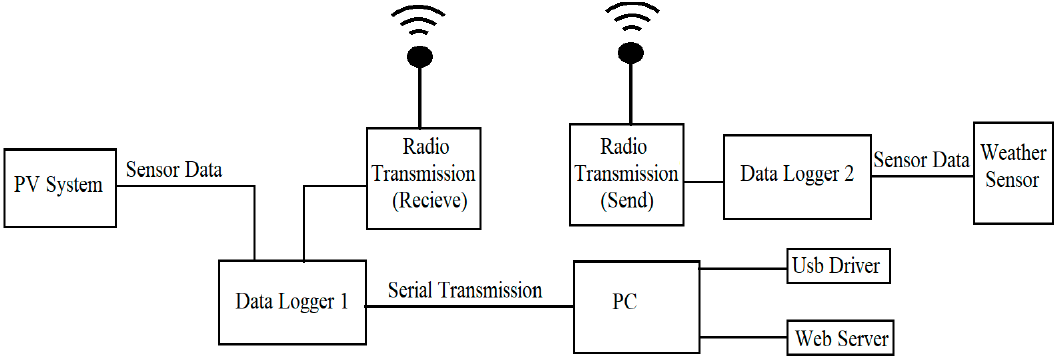
Figure 1. Overall system schematic.